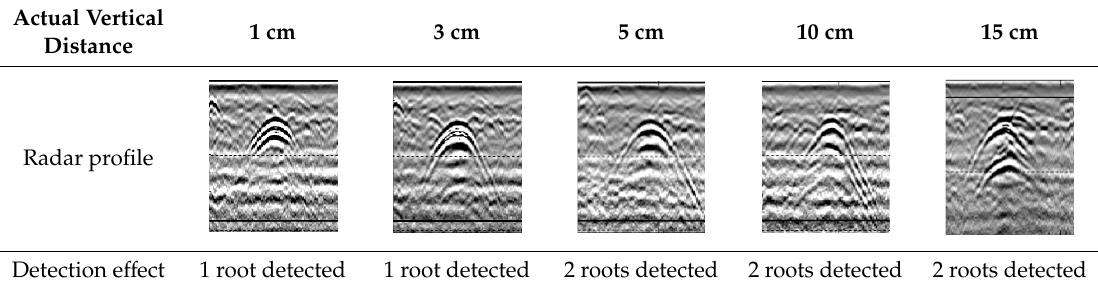
Table 4. Radar profiles of roots buried at different vertical distances from one another.